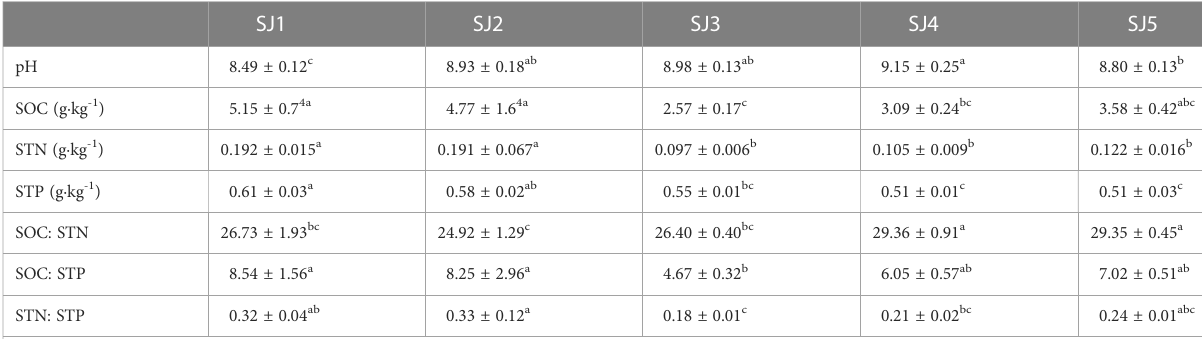
TABLE 3 Soil pH, C, N, P, and stoichiometric characteristics (C: N, C: P, N: P) among different habitats in the Daliyabuyi oasis. SJ1 SJ2 SJ3